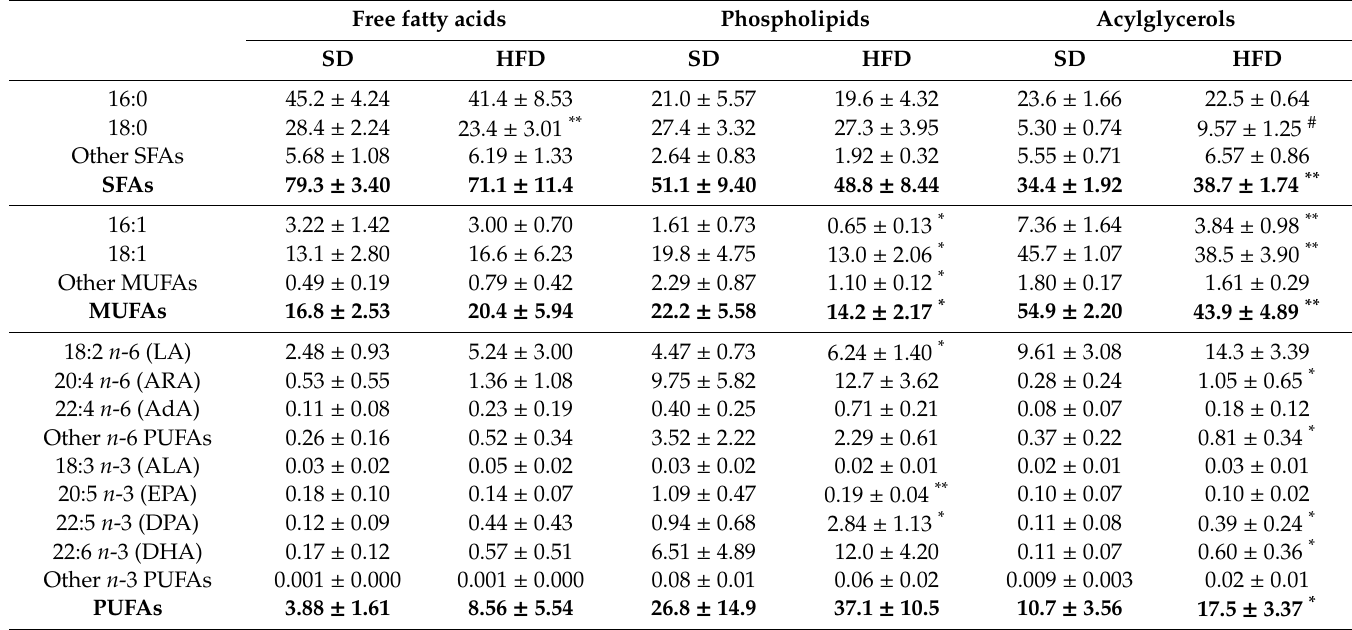
Table 3. FA content (%) in heart fractions obtained with the Kaluzny et al. [62] method. Free fatty